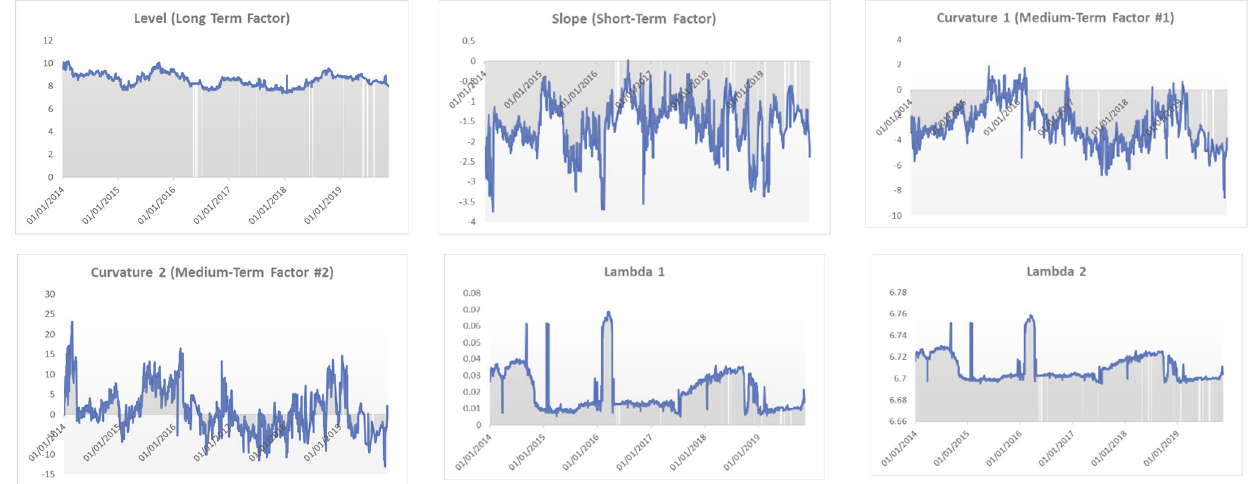
Fig. 3 . Model 3 result (level, slope, curvature 1, curvature 2, lambda 1 & lambda 2)